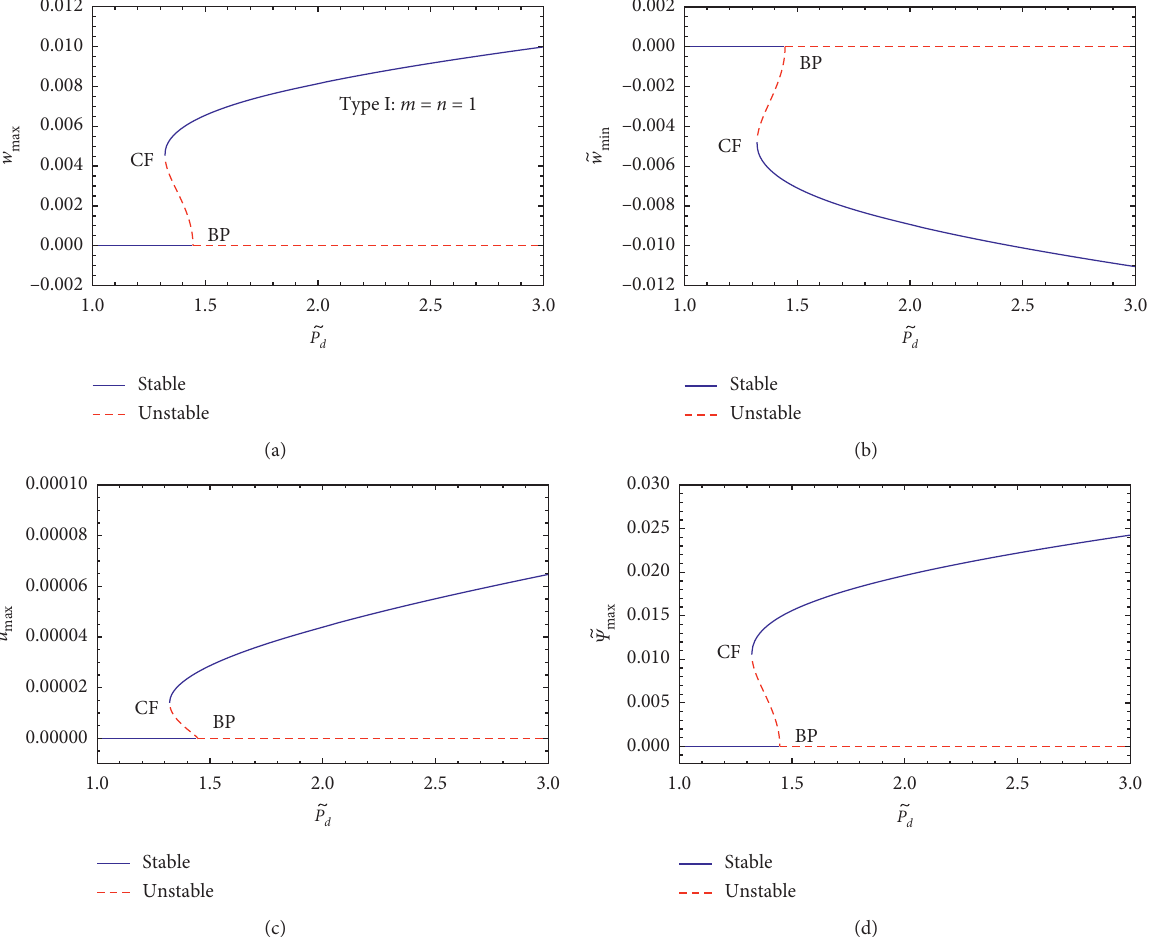
Figure 9: Force-response curves of the couple motions of BDFG beam with m � n � 1, L / h � 20, 􏽥 c (a, b) Maximum and minimum amplitudes of transverse motion 􏽥 w . (c) Maximum amplitudes of longitudinal motion 􏽥 u . (d) Maximum amplitudes of rotational motion ψ